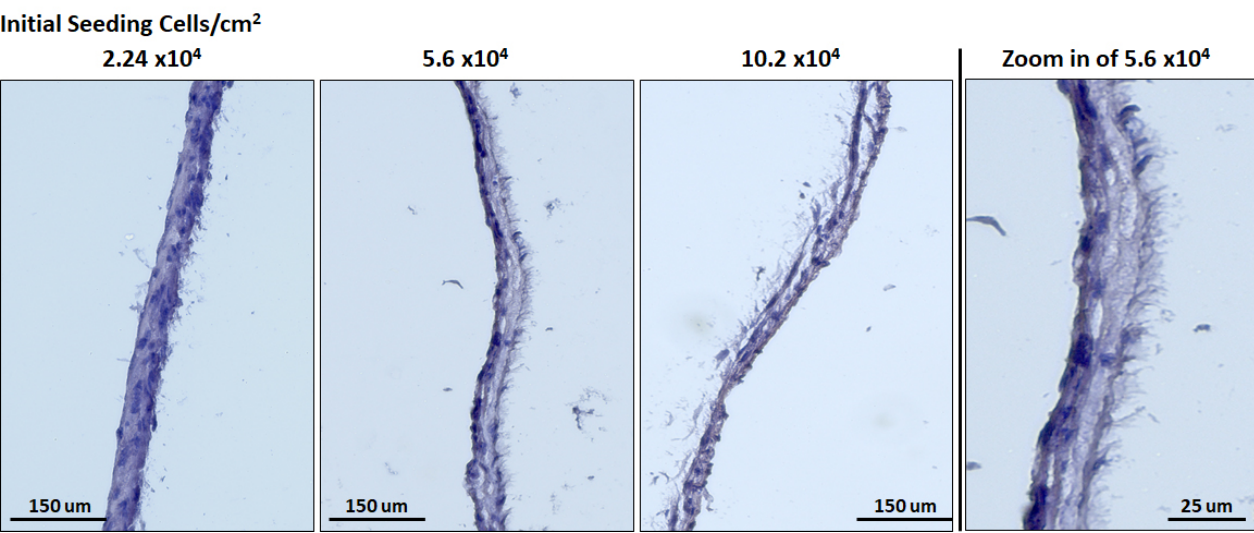
Figure 7. H&E on the undifferentiated cell sheets harvested at 12 days, initially seeded with 2.24 × 10 4 , 5.6 × 10 4 , 10.2 × 10 4 ASC per cm 2 . The figure on the right shows a zoom in of the cell sheet engineered with 5.6 × 10 4 per cm 2 , and microvilli can be observed on the apical side of the cell sheets.